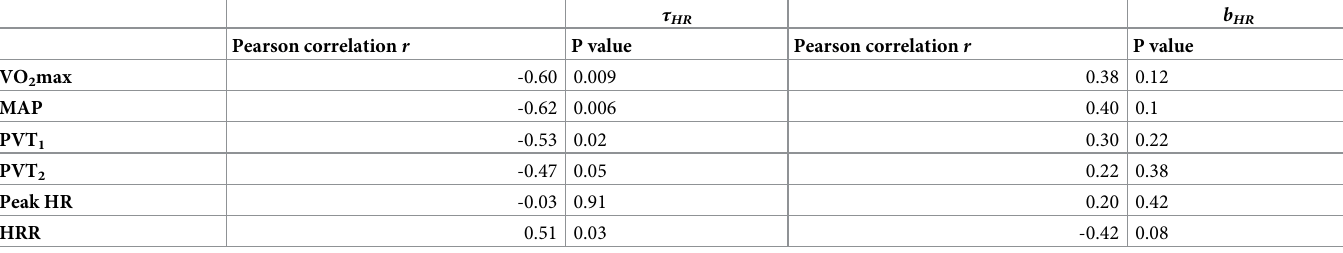
Table 3. Pearson linear correlation coefficients r with the associated p value between the estimated HRV decay coefficients obtained with model 1 (HRV decay con- stant τ HR and the HRV at HR = 0 b HR ) and cardiorespiratory fitness indices: Maximum oxygen consumption (VO2max), maximum aerobic power (MAP), maxi- mum experimental heart rate Peak HR power at the first and second ventilatory threshold (PVT1 and PVT2) and heart rate recovery (HRR).